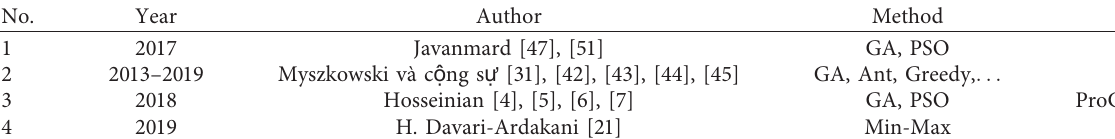
Table 1: Summary of early